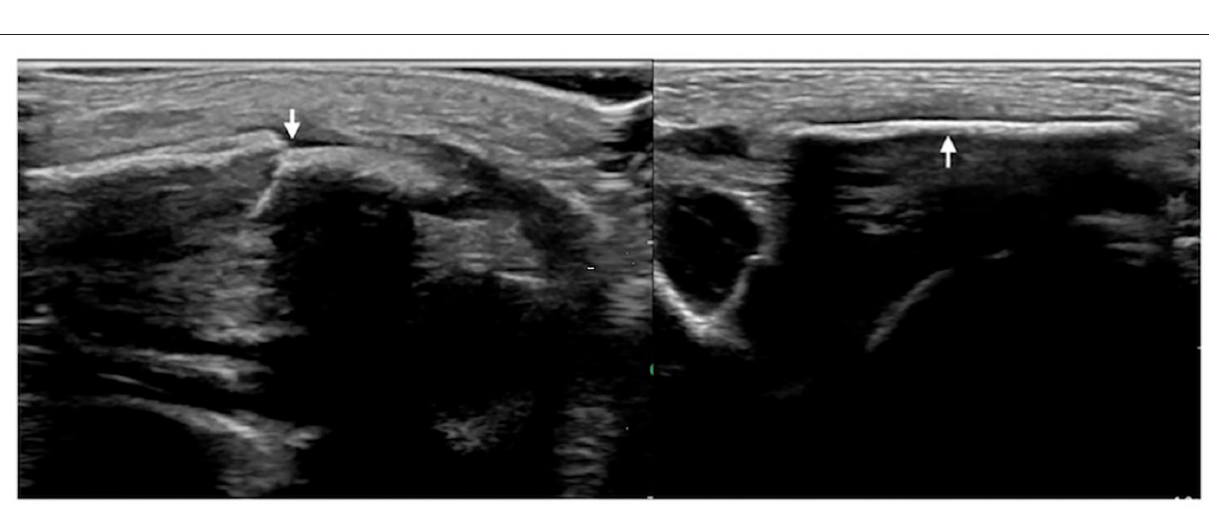
FIGURE 3 | Left clavicle fracture. The infant was G 4 P 2 with a gestational age of 41 weeks, forceps delivery, and a birth weight of 3,670g. The patient was admitted to the hospital 41h after birth due to jaundice for 6h. Physical examination revealed asymmetrical clavicles as well as local swelling and bone rubbing on the left side. Ultrasound showed interrupted cortical continuity, broken end formation, and dislocation in the left midclavicular segment (left); the right clavicular continuity was intact, and the cortical bone was